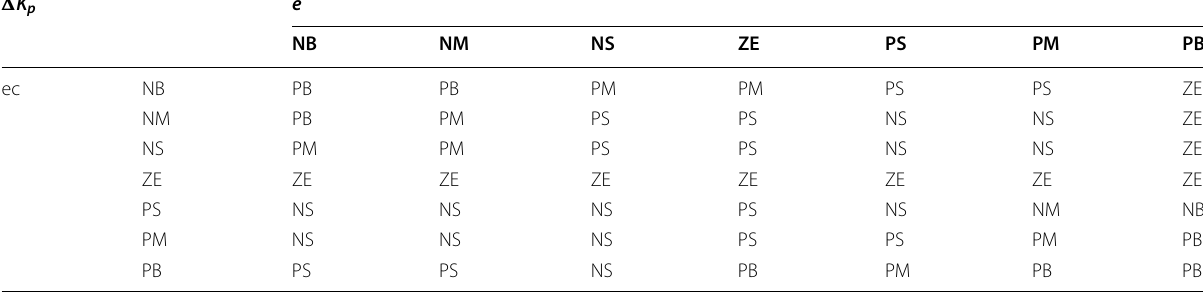
Table 1 Fuzzy control rule table of (cid:31) K